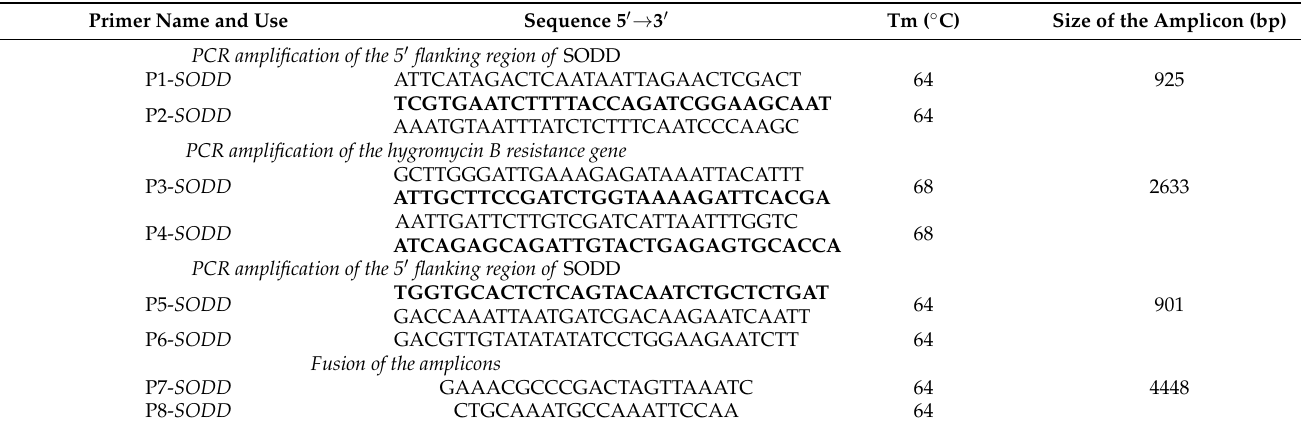
Table 1. List of primers used for construction of the cassette for SODD gene disruption.